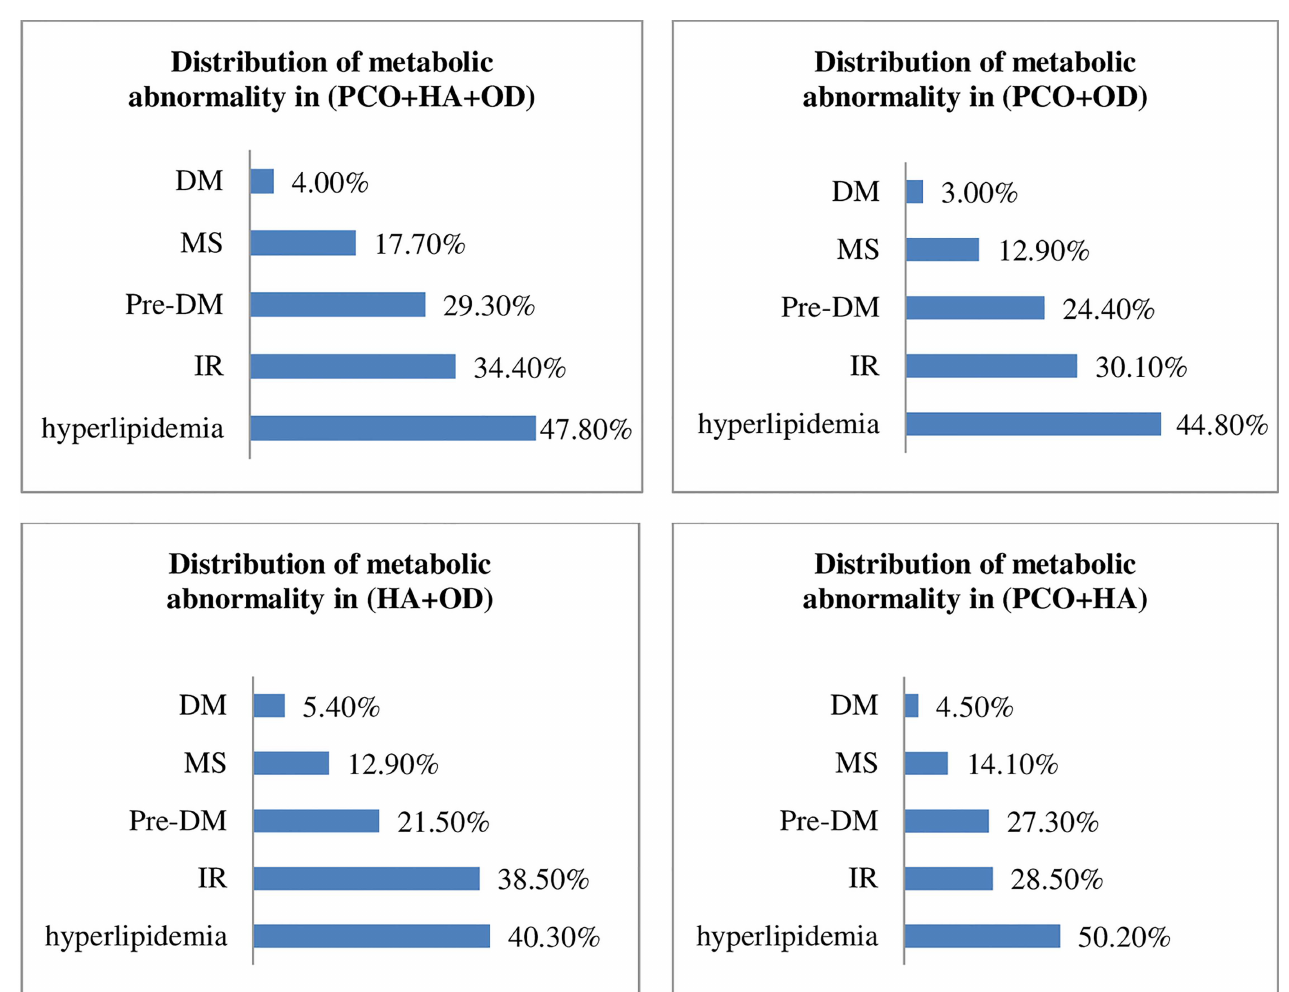
Fig 2. Distribution of metabolic abnormalities in the indicated PCOS phenotypes. [DM: diabetes mellitus, IFG: impairedfasting glucose,IGT: impairedglucosetolerance, IR: insulinresistance, MS: metabolicsyndrome,pre-DM: pre-diabetes mellitus, includingIFG and IGT. PCO+HA+OD is the classic reproductive phenotype which has polycystic ovary morphology, androgenexcess and ovulationdysfunction. PCO+HA is the ovulatory phenotype which has polycystic ovary morphology and androgenexcess with ovulation. PCO+OD is the phenotype that has polycystic ovary morphology and ovulationdysfunctionwithout androgenexcess. HA+OD is the phenotype that has androgenexcess and ovulation dysfunctionwithout polycystic ovary morphology.]